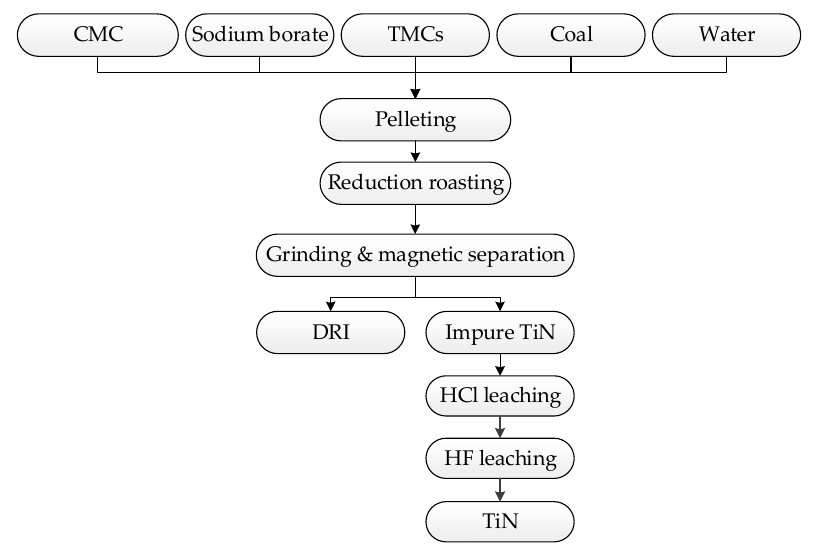
Figure 1. Experimental procedure .